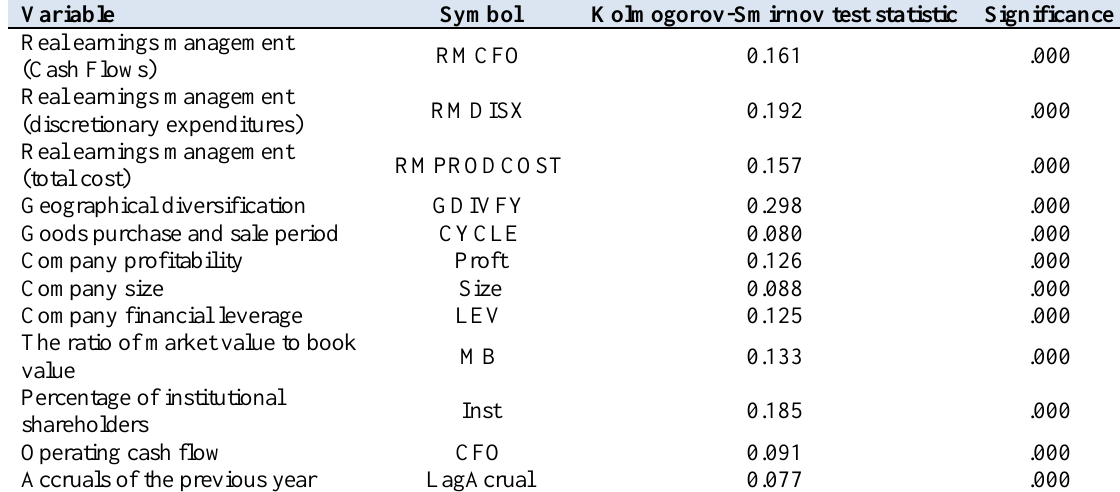
Table 3. The normality of Research